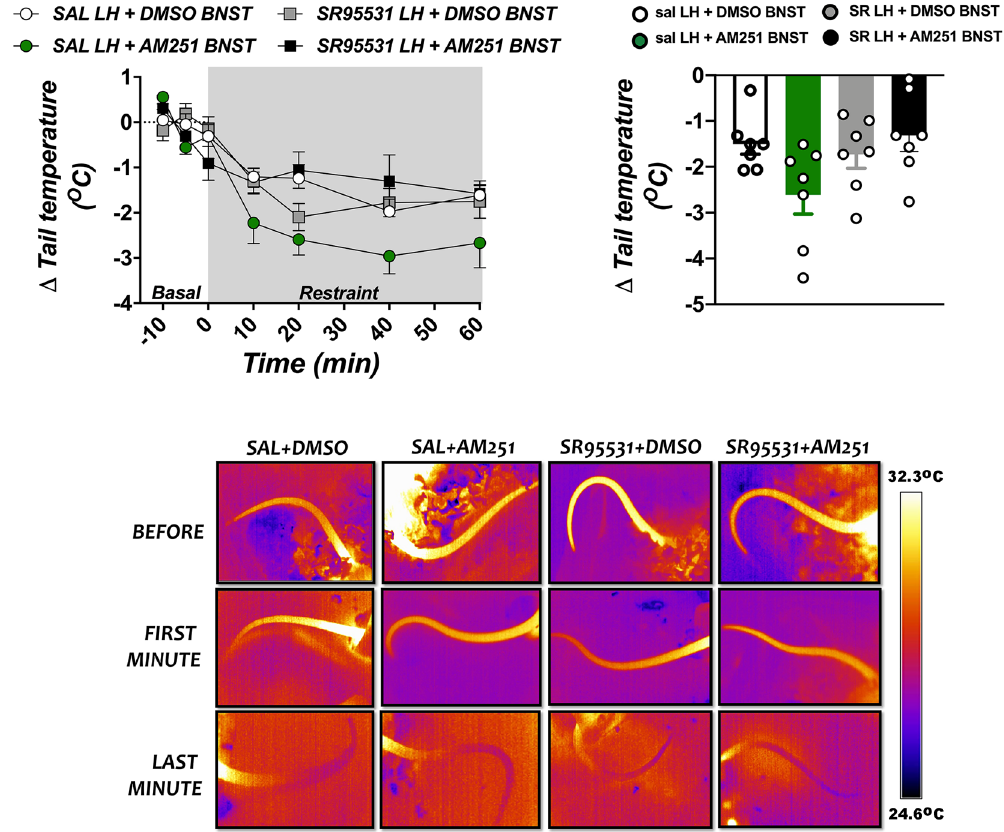
Figure 3. Effect of lateral hypothalamus (LH) treatment with the selective GABA A receptor antagonist SR95531 and/or microinjection of the CB 1 receptor antagonist AM251 into the bed nucleus of the stria terminalis (BNST) in drop in tail skin temperature evoked by an acute session of restraint stress. (Top, left) Time-course curves of changes in tail skin temperature (Δ tail temperature) evoked by acute restraint stress in animals treated bilaterally into the LH with saline (SAL, 100 nL) or the selective GABA A receptor antagonist SR95531 (1 pmol/100 nL), followed by a second microinjection into the BNST of vehicle [solution of saline containing 30% of DMSO (DMSO), 100 nL] or the selective CB 1 receptor antagonist AM251 (AM251, 100 pmol/100 nL). Circles represent the mean ± SEM. Two-way ANOVA (n = 7/group). (Top, right) Mean Δ tail temperature during the entire restraint stress period in animals treated bilaterally into the LH with SAL (100 nL) or SR95531 (1 pmol/100 nL), followed by a second microinjection into the BNST of DMSO (100 nL) or AM251 (100 pmol/100 nL). Columns represent the mean and bars the SEM. One-way ANOVA (n = 7/group). (Bottom) Images of representative rats showing the tail skin temperature before and at first and last minute of restraint stress in animals treated with saline (SAL) or the selective GABAA receptor antagonist SR95531 into the LH, followed by a second microinjection of vehicle (DMSO) or the selective CB 1 receptor antagonist AM251 (AM251) into the BNST. Note the absence of effect of the pharmacological